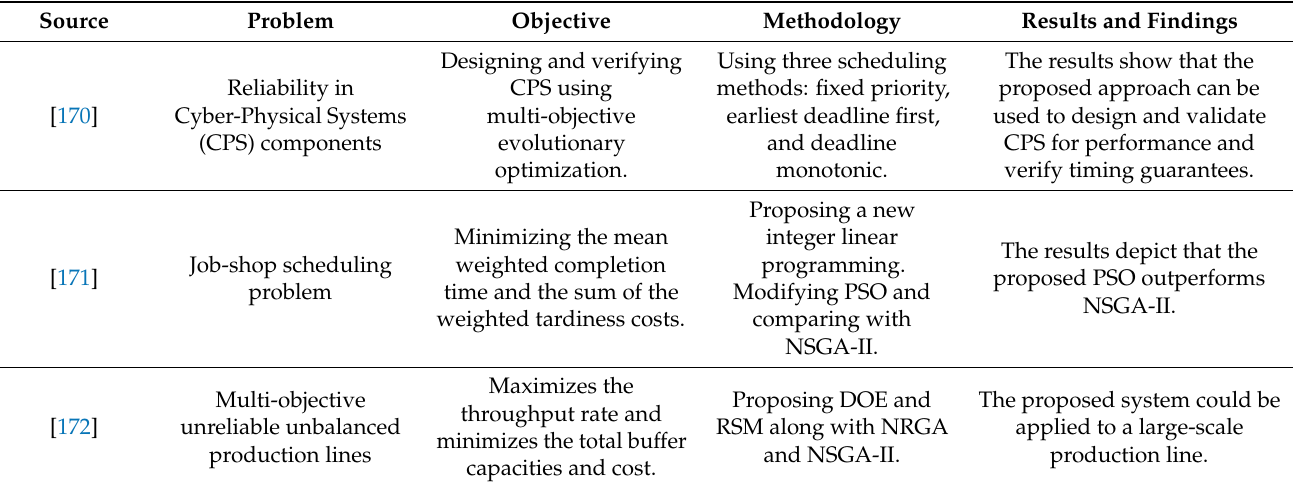
Table 4. Summary of the literature review on NSGA-II applications in different fields, along with methodology and